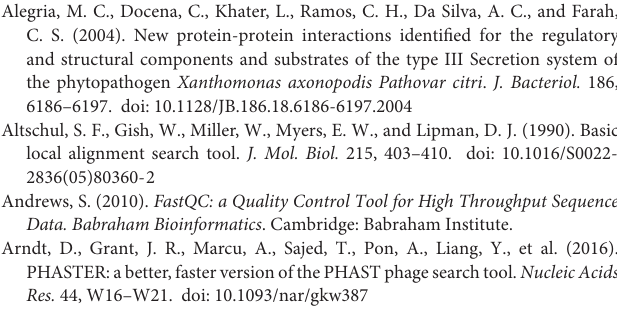
Supplementary Figure 2 | Phylogenetic analysis based on whole genome comparison. The asterisks indicate copper-resistant strains. Supplementary Figure 3 | Shared and unique protein coding genes in three sequenced strains. Supplementary Figure 4 | Pangenome analysis of 79 X. citri genomes. Supplementary Figure 5 | Type II and III secretion systems. (A) Two operons of the type II secretion system. (B) Gene cluster of the type III secretion system.